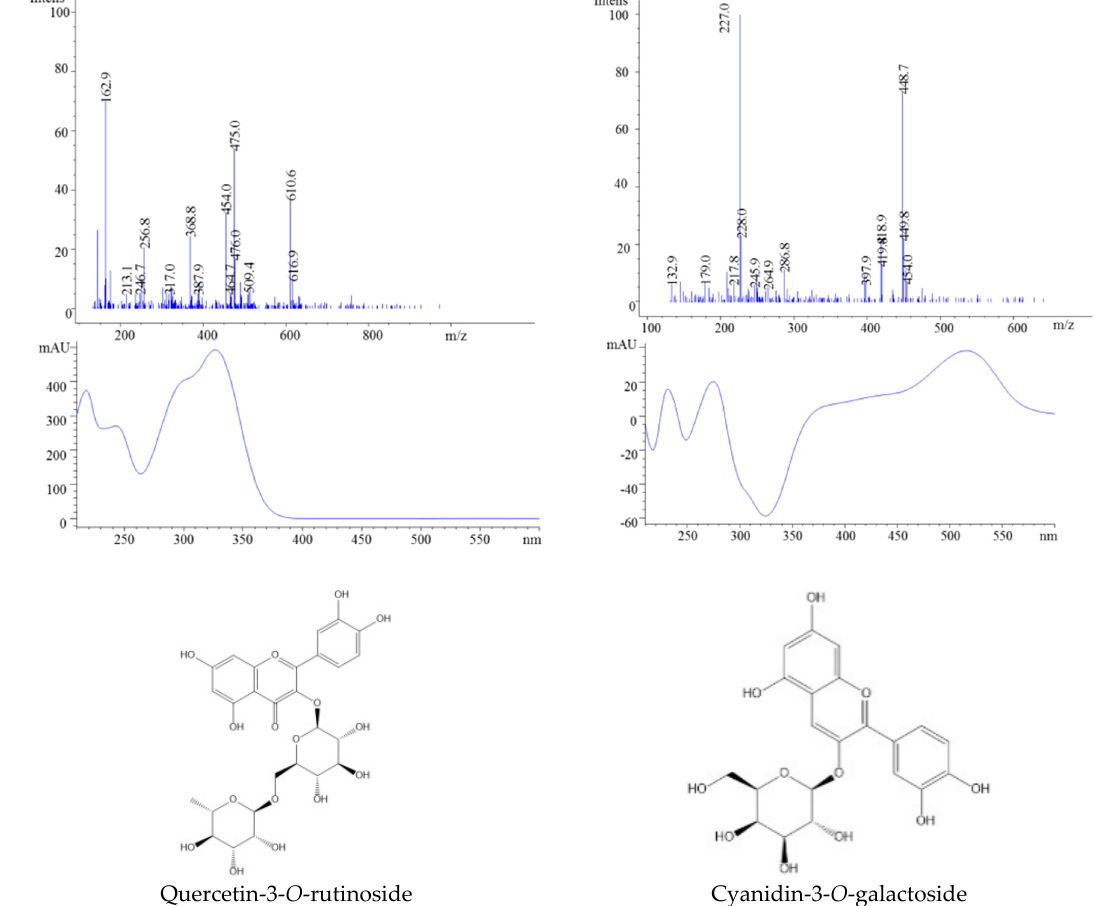
Figure 2. HPLC-MS spectra, UV/vis scanning spectra, and the chemical structures of peaks 3 and 7.